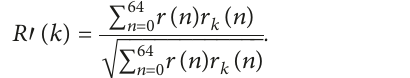
figure that (b) can track the resonance peaks of the speech spectrum and weaken the energy between the resonance peaks, but this filter introduces a spectral tilt. By adding the spectral tilt compensation filter, the spectral tilt of the filter synthesized speech has to undergo spectral tilt compensation and adaptive gain control after entering the short-time filter, and these three modules are one and the same.